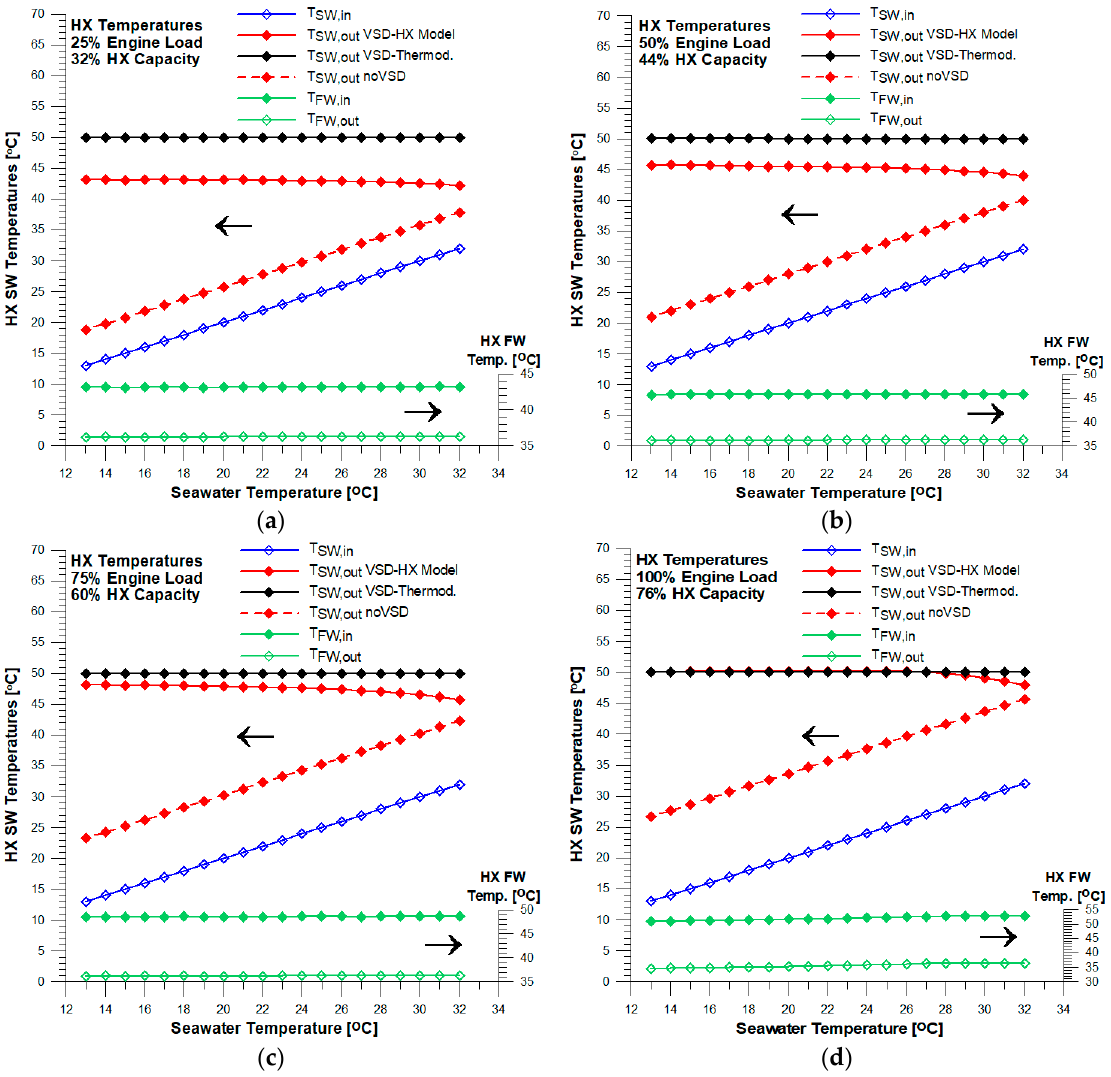
Figure 7. Comparison of heat exchanger FW and SW inlet and outlet temperatures, with VSD scheme and constant pump speed, for various SW inlet temperatures, at ( a ) 25%, ( b ) 50%, ( c ) 75% and ( d ) 100% of full engine load.